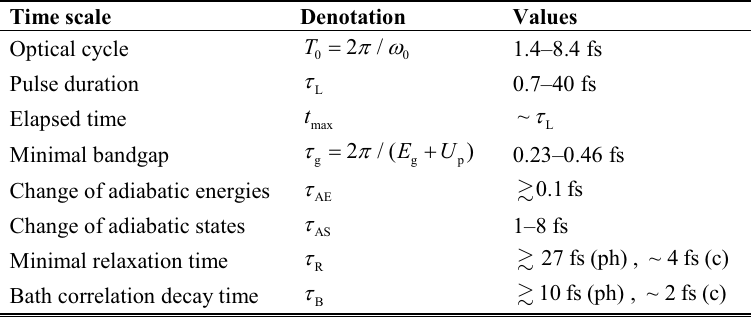
Change of adiabatic energies Change of adiabatic states Minimal relaxation